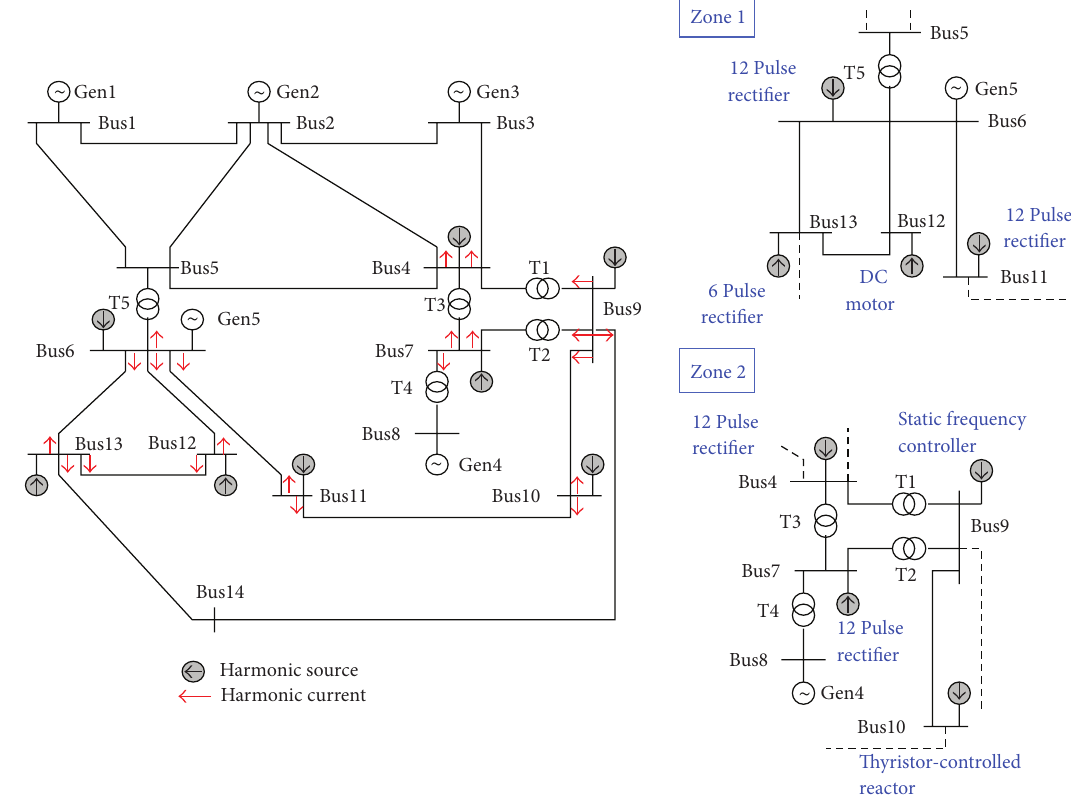
Figure 4: One-line diagram of the 14-bus power system.